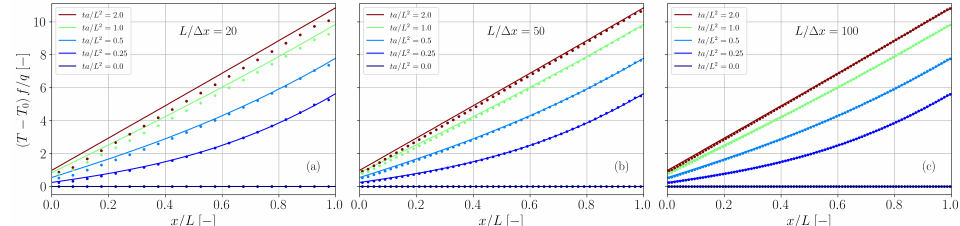
Figure 22. Comparison of simulation results (dots) and analytical solution (solid lines, Equation (67)) for the temperature distribution in a plate with heat transfer and heat flux. The spatial resolution is varied between L / ∆ x = 20 ( a ), L / ∆ x = 50 ( b ) and L / ∆ x = 100 ( c